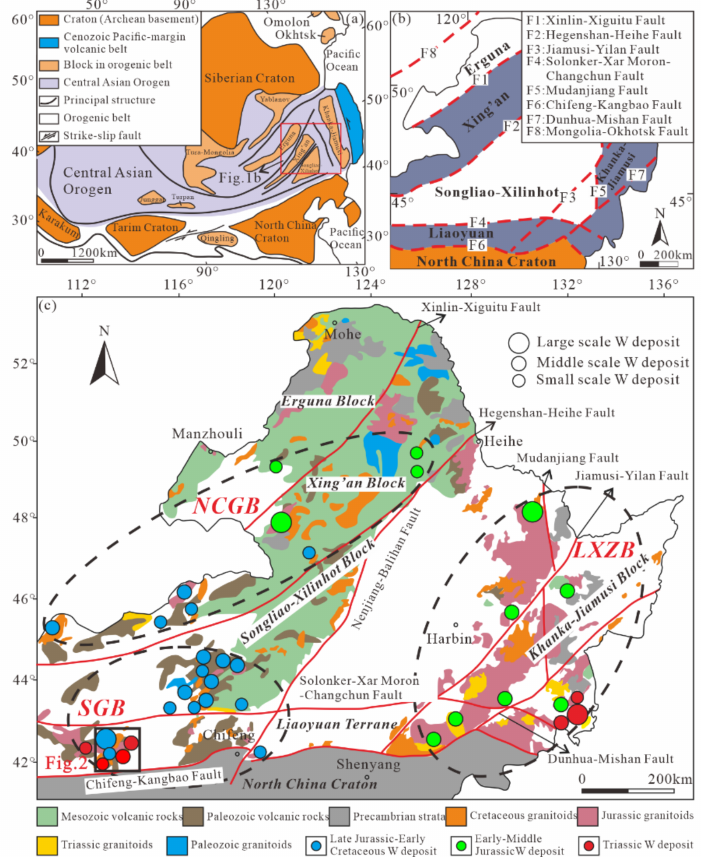
Figure 1. ( a ) Simplified tectonic map of the Central Asian Orogenic Belt (modified from [37]). ( b ) Schematic tectonic map of NE China (modified from [38]). ( c ) Distribution of major tungsten deposits in NE China (modified from [8]). Abbreviations are as follows: NCGB = the northern and central Great Xing’an Range W belt; SGB = the southern Great Xing’an Range W belt; LXZB = the Lesser Xing’an-Zhangguangcai Range W